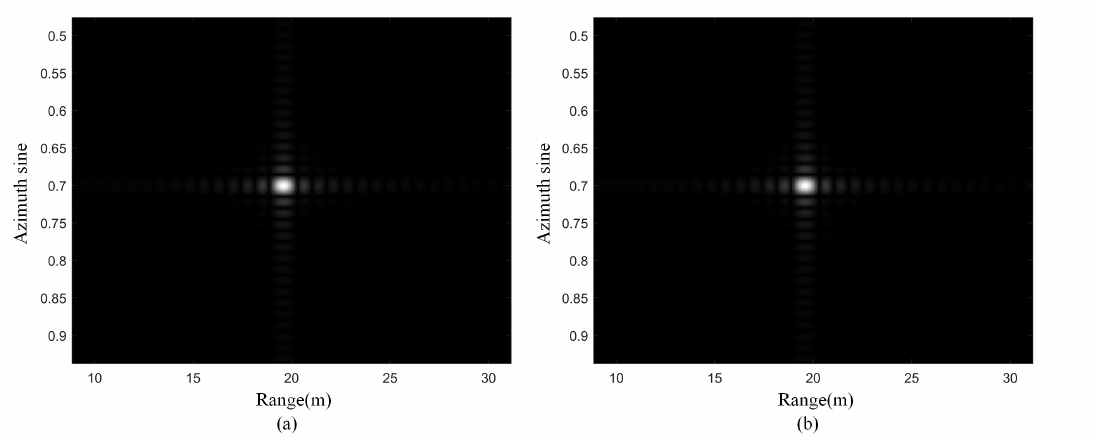
Figure 14. Imaging results of point target simulation. ( a ) Imaging results based on interpolation method. ( b ) Imaging results of the method proposed in this paper.